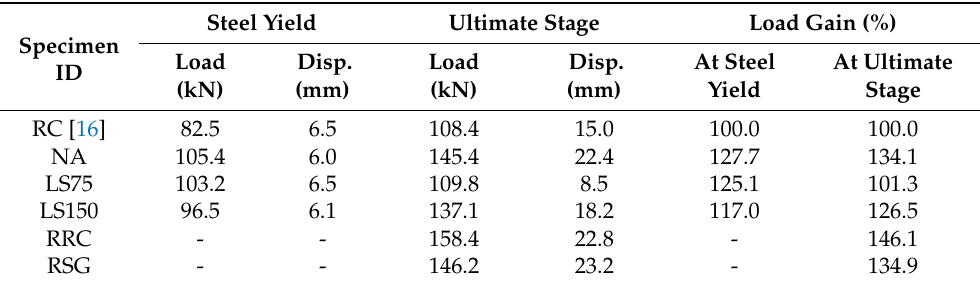
Table 7. Results of failure test for RC slab specimens.